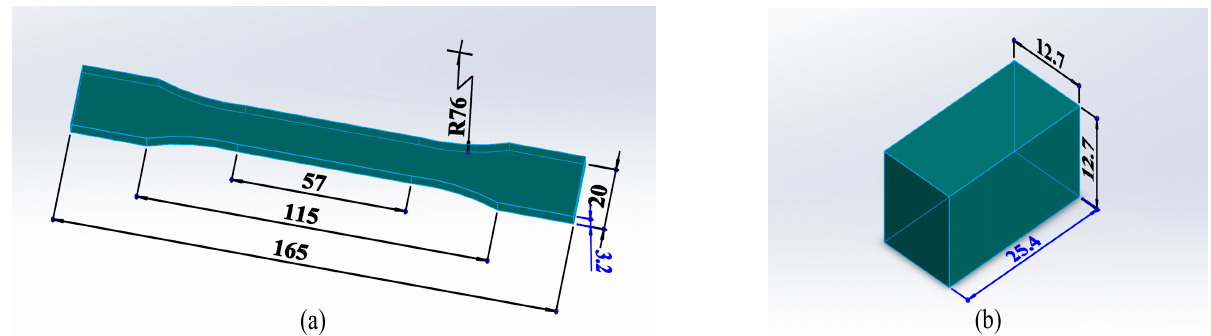
Figure 3. The dimension of the test samples: ( a ) tensile; ( b ) compressive.